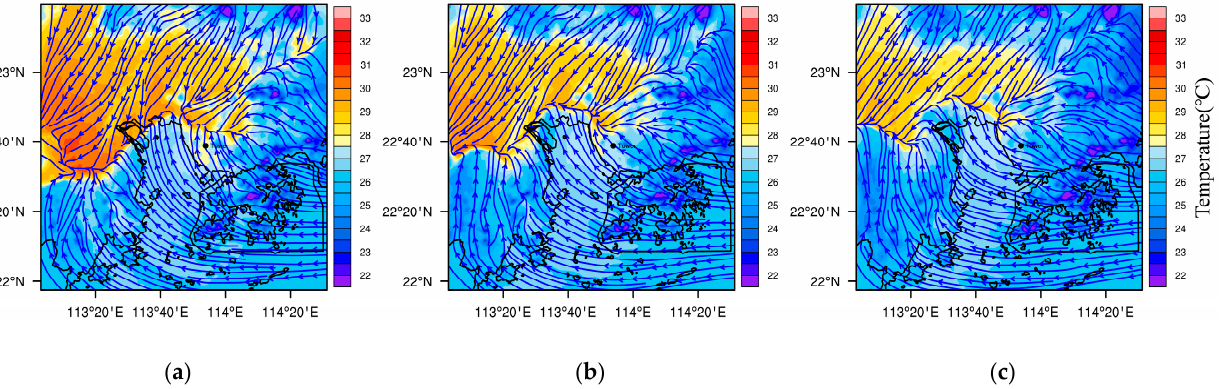
Figure 6. The wind streamlines and temperature field near the surface from the WRF model on 25 September 2019. ( a ) at 19:00; ( b ) at 20:00; ( c ) at 21:00. The black dot represents the observation site. The simulation results of wind from WRF are validated using observations from lidar. Figure 7 and Figure 8 show the comparison of wind speed and wind direction between lidar observation and WRF at 17:00–22:00. Before the sea breeze appeared, the results of WRF were relatively accurate. At 18:00, the wind direction near the surface was SSW at the observation site from WRF, but the result of lidar was SE. The deviation of simulated wind direction decreases with the altitude increases. Therefore, the deviation near the surface may be caused by the complex underlying surface and the urban heat island effect. The sea breeze layer thickness simulated by WRF is about 400 m higher than the observation from 19:00 to 20:00, and the simulated thickness is lower than the observation at 22:00. As a result, the wind speed has large deviations at certain heights. The comparison results prove that WRF can simulate the evolution during the sea breeze. These deviations may be caused by limitations of the model parameterization schemes or the differences between the topography of the model and the actual environment of the experimental site.